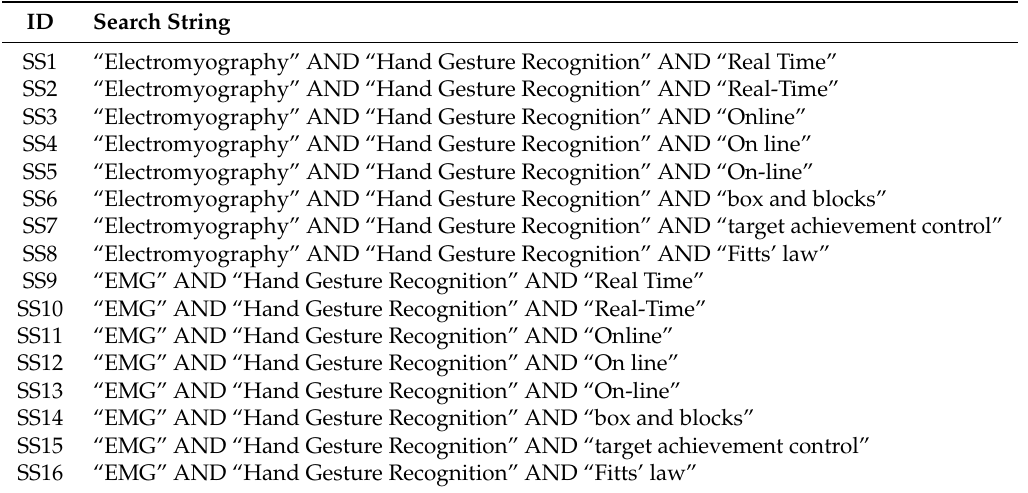
Table 1. Search strings used to find primary